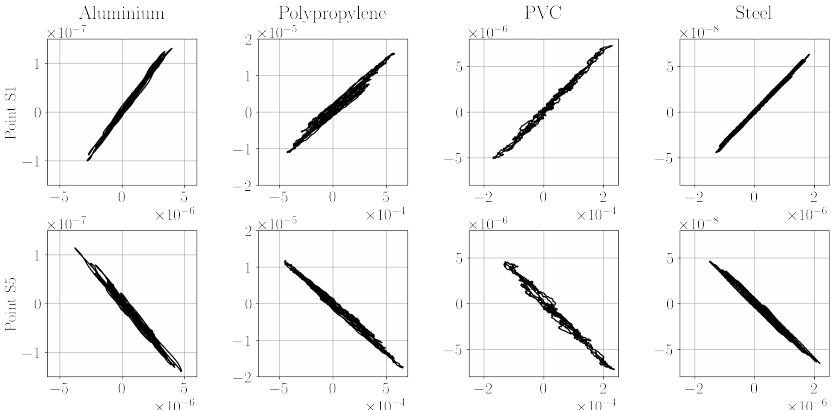
Figure 9. Displacement d y - d x trajectories of points S1 and S5 for each material (in